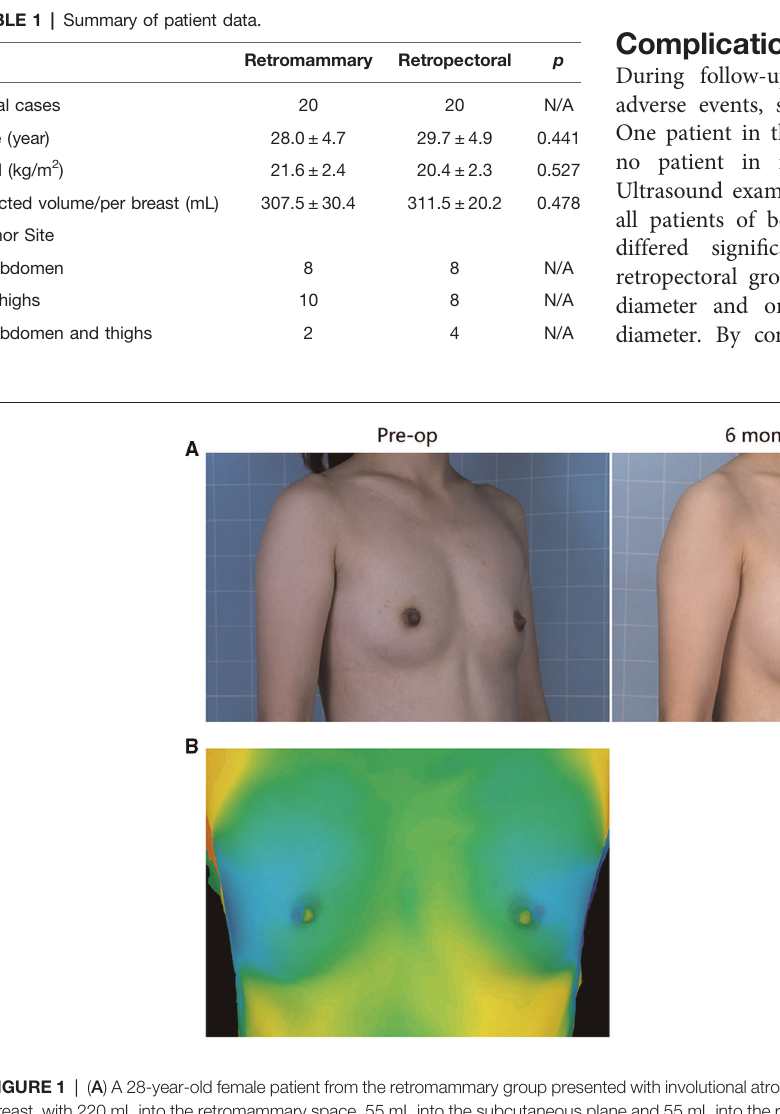
FIGURE 1 | ( A ) A 28-year-old female patient from the retromammary group presented with involutional atrophy of the breasts. She received 330 mL lipoaspirates per breast, with 220 mL into the retromammary space, 55 mL into the subcutaneous plane and 55 mL into the retropectoral space. Six months after surgery, each breast was augmented. ( B ) The 3D laser scanner demonstrated the volume change before and after